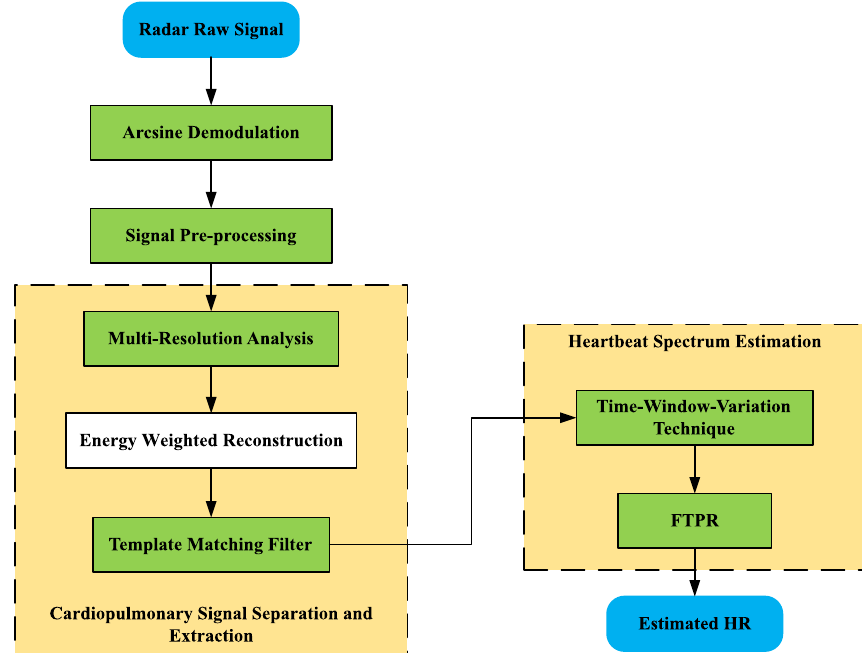
Fig. 2 Flowchart of the proposed HR estimation